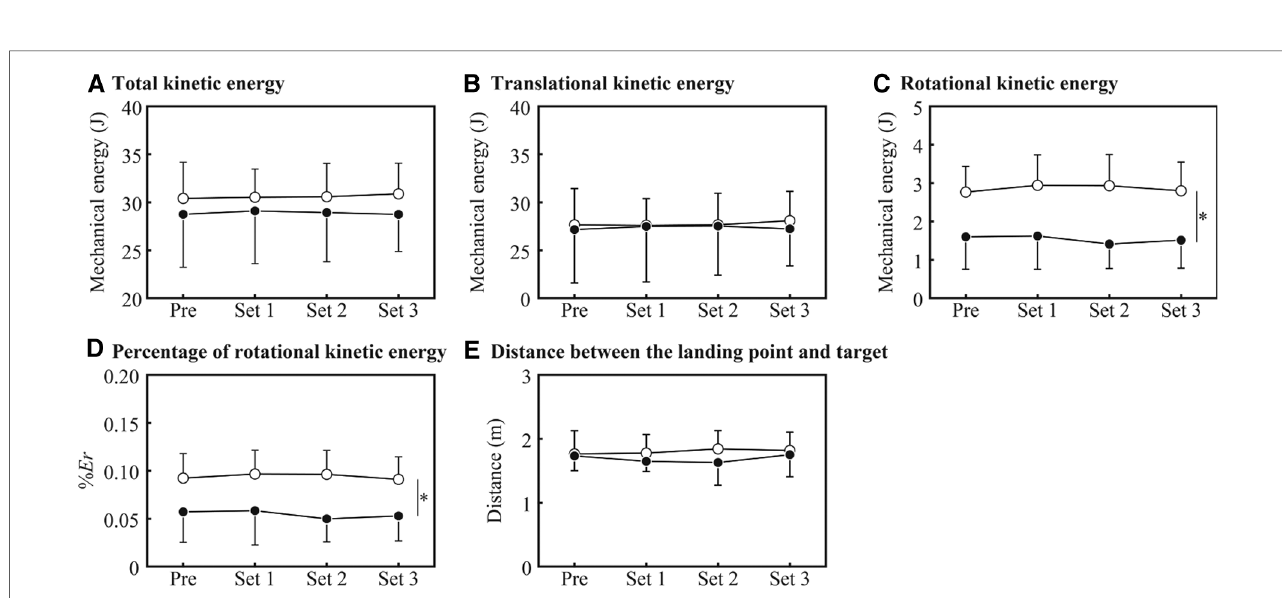
FIGURE 3 Results of the hitting test at each time point. White and black circles indicate the HIGH and LOW groups, respectively. An asterisk indicates a main effect between